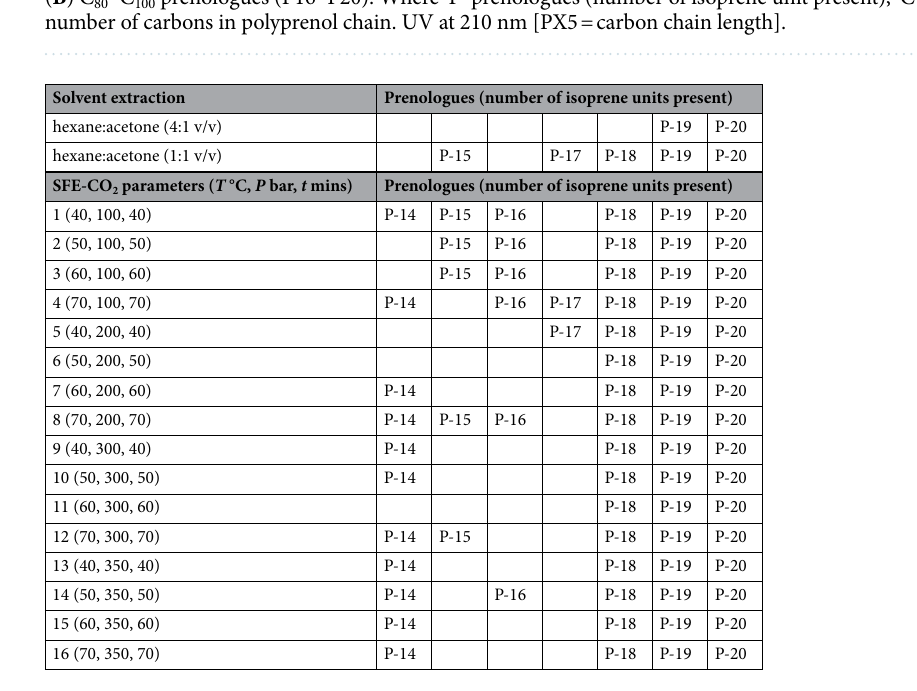
Table 2. Polyprenol chain length identified from HPLC chromatogram in C. atlantica ‘Glauca’ . The plant needles were extracted with two different extraction solvent and under 16 different SFE-CO 2 parameter